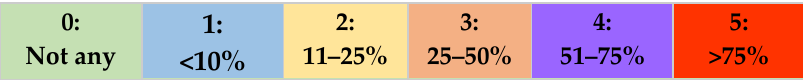
Figure 2. 0–5 Scale: Appearance of symptoms on the leaf area (%).